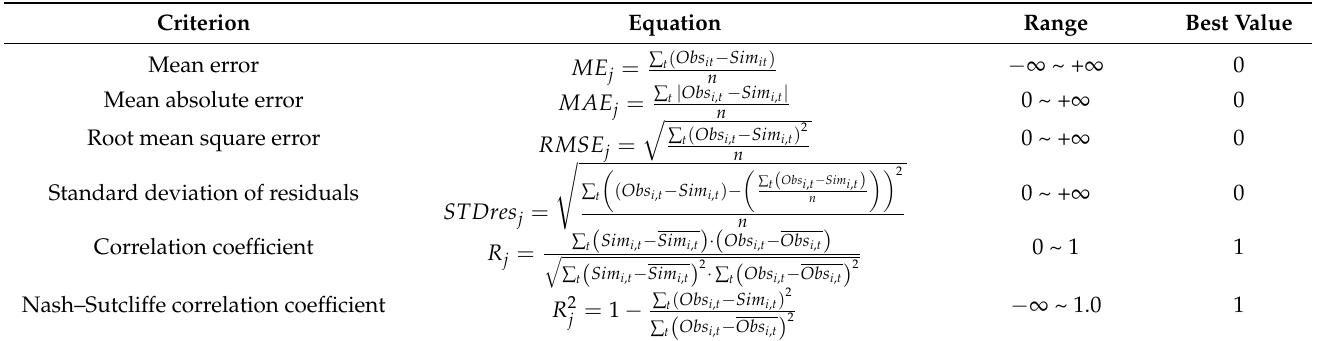
Table 2. Statistical criteria for evaluating the performance of the Lake Zazari basin hydrologi- cal